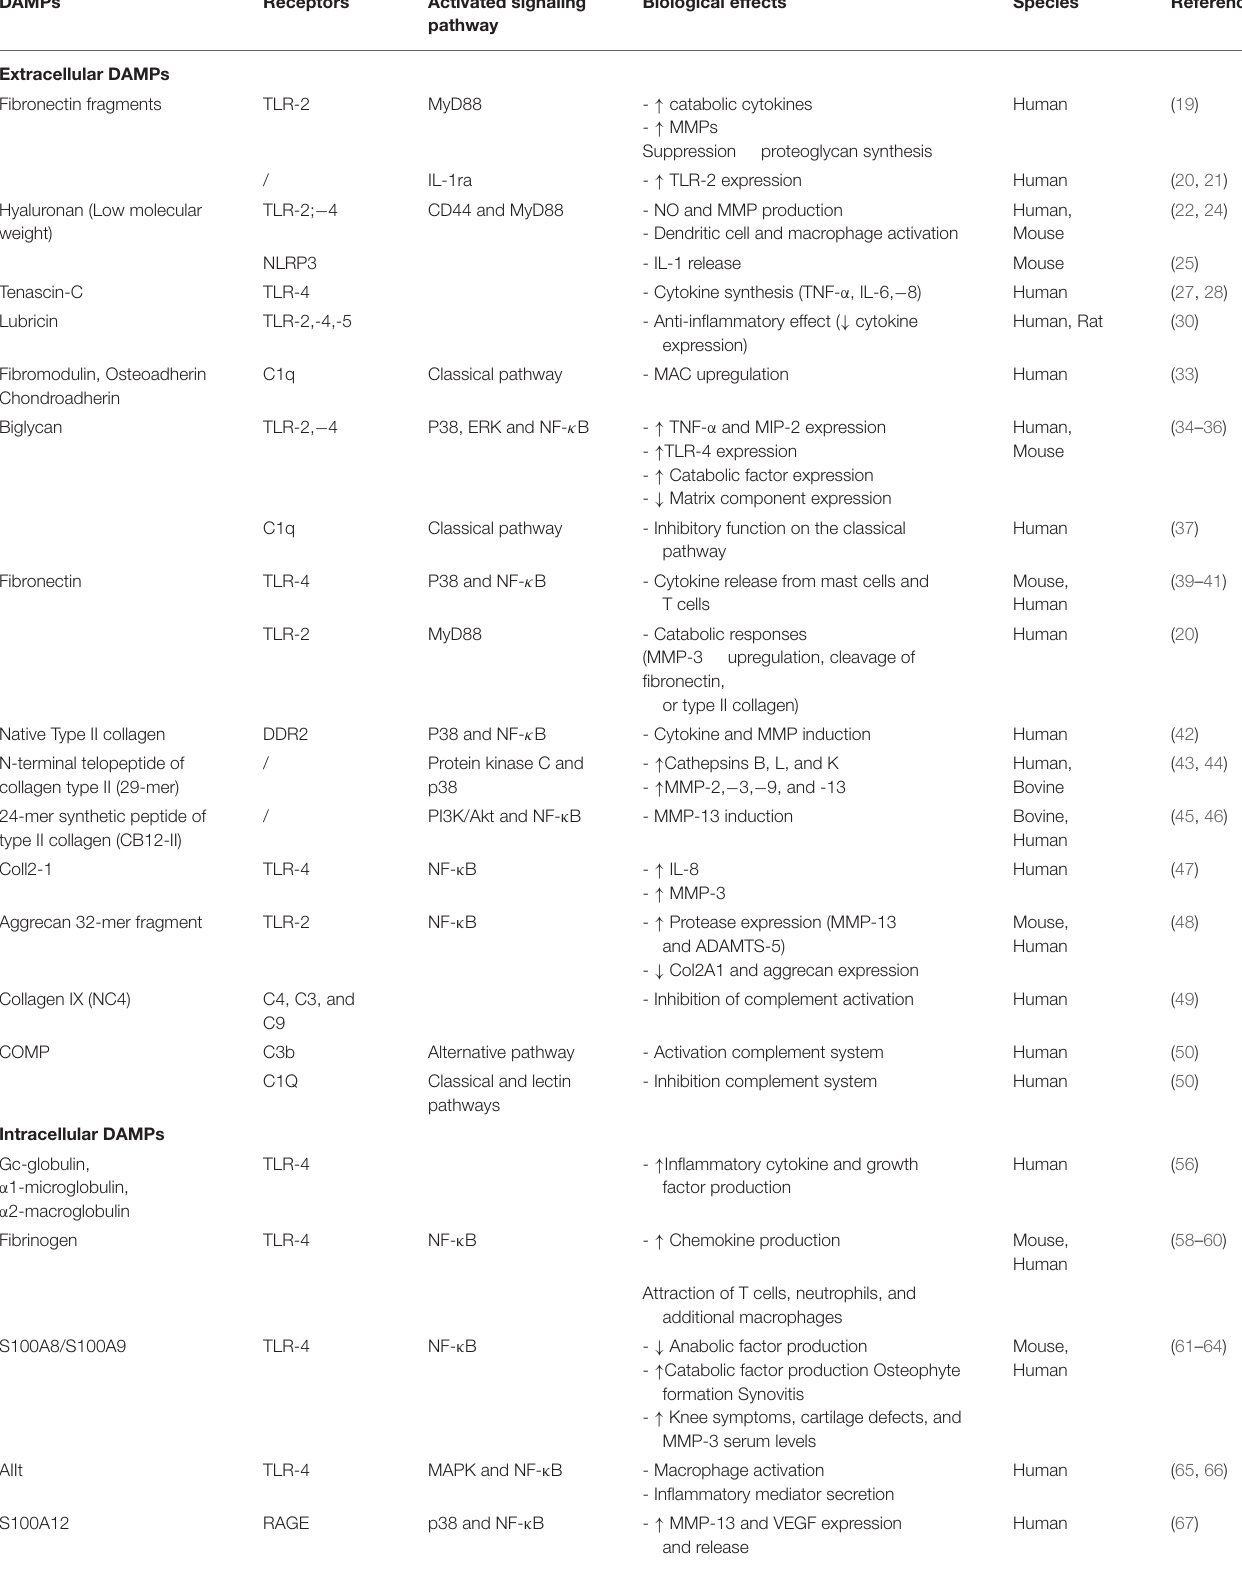
TABLE 1 | Overview of DAMPs and their implications in the OA